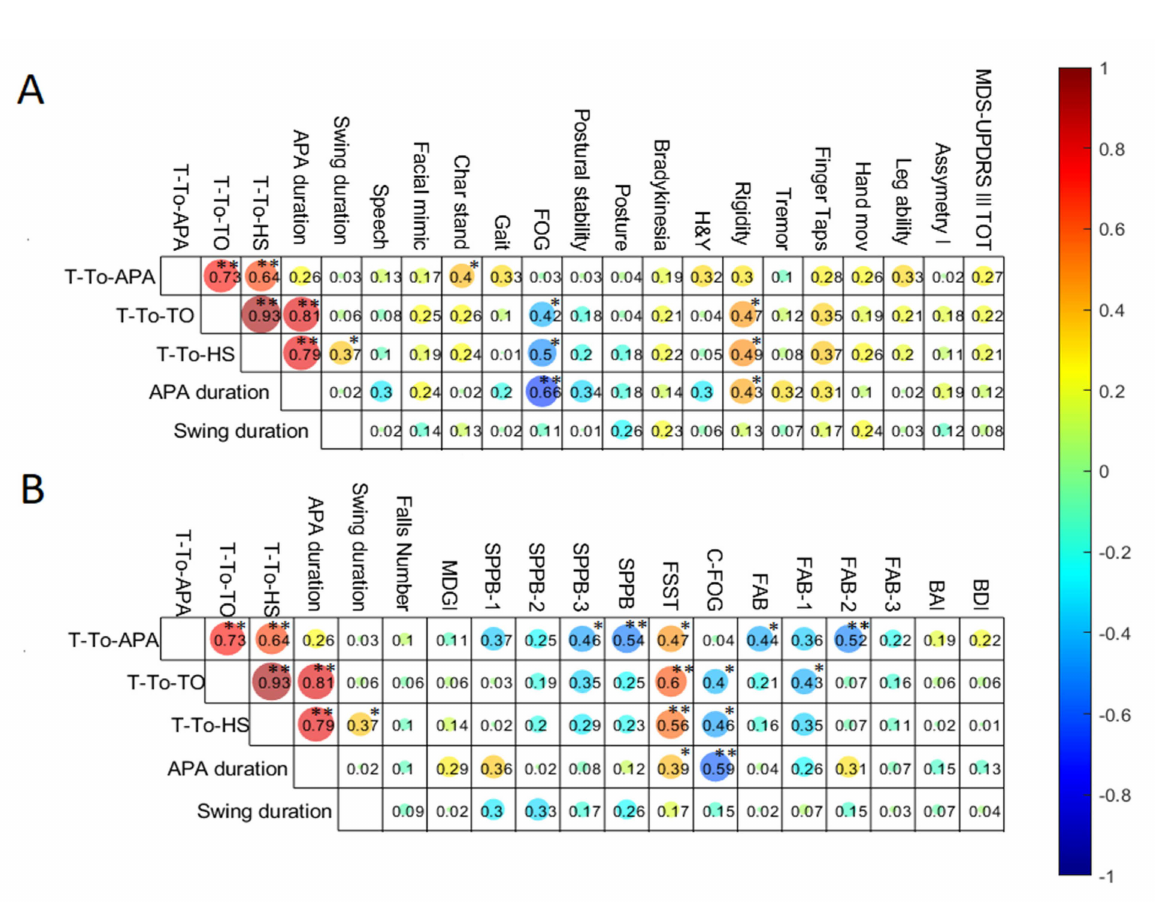
Figure 3. Correlations between gait initiation metrics and clinical outcomes for MDS-UPDRS III and its sub-items ( A ) and the other clinical scales ( B ). Absolute values are reported in the boxes, whereas the circle color indicates the positive (red) or negative (blue) degree. Significant correlation indices are indicated with * p < 0.05 and ** p < 0.01. H&Y stage, Hoehn and Yahr stage; MDS-UPDRS III, Unified Parkinson Disease Rating Scale Part III; MDGI, modified Dynamic Gait Index; SPPB short physical performance battery; FSST Four Step Square Test; C-FOG, Characterizing Freezing of Gait; FAB Frontal Assessment Battery; BAI, Beck Anxiety Inventory; BDI-II Beck Depression Inventory. Table 4. Gait initiation metrics for both groups, PD and